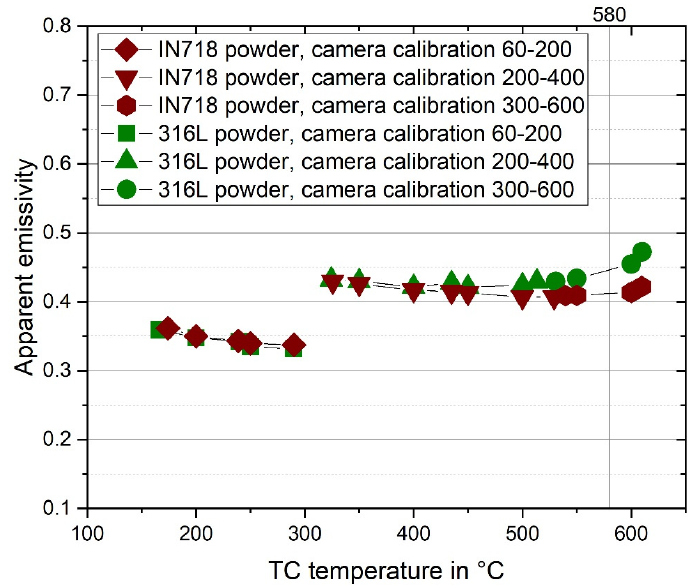
Figure 12. Comparison of apparent emissivity results of IN718 powder layer (brown full symbols) and 316L powder layer (green symbols) over measured TC temperature.